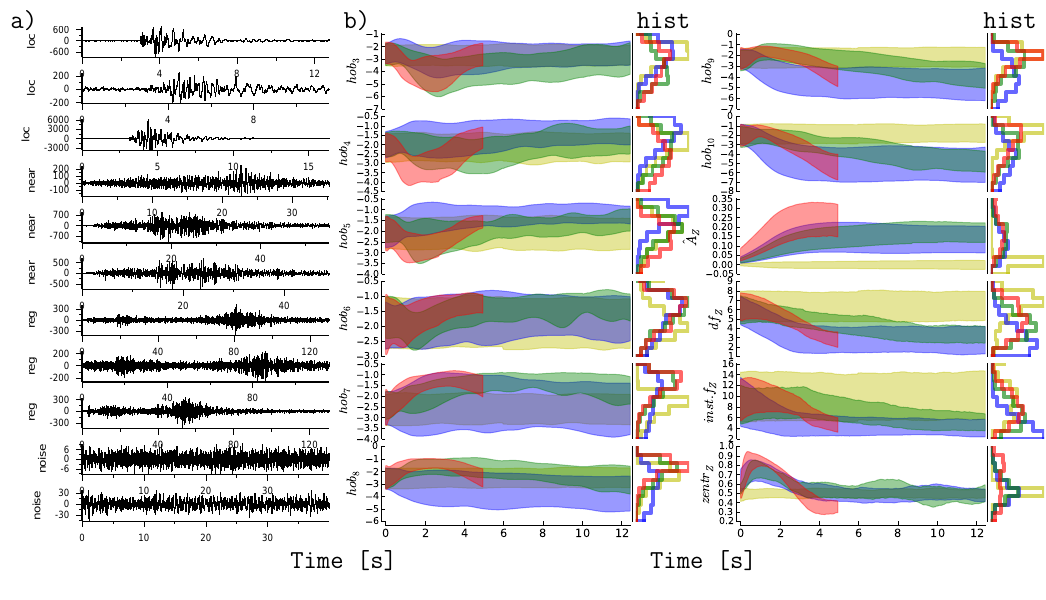
Fig. 1. Training data examples (a) and characteristic functions (b) generated from the training data set (plus/minus one standard deviation around the mean). Color-coding: reg in blue, near in green, loc in red, noise in yellow. A histogram over the timespan is appended vertically for each characteristic function in (b) . 3s were subtracted from the start and added to the end of each sample in (a) to emphasize the contrast to the